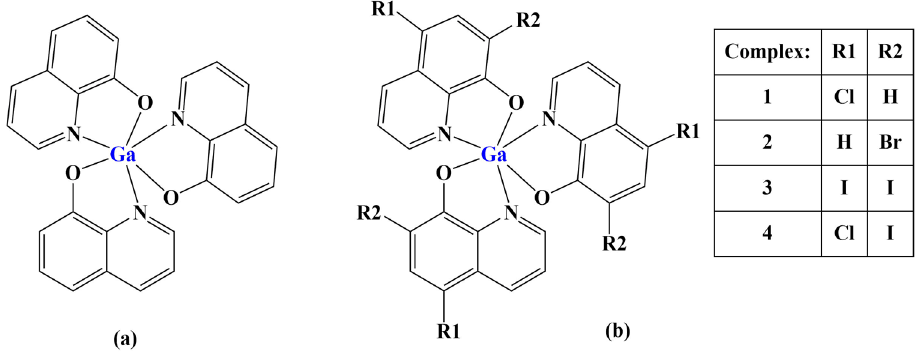
Figure 24. Structures of KP46 ( a ) and its analogues ( b ) presented in [94,95]. Complex 1 (with 5-chloro-substituted ligand) manifested the most pronounced antiproliferative effect (IC 50 = 6.5–14.0 µ M), comparable to that of the positive control cisplatin with regard to the various cell lines. Non-cancerous cells were affected at 25–65 times higher concentrations than cancer cells. The complex was significantly more active than the ligand itself.